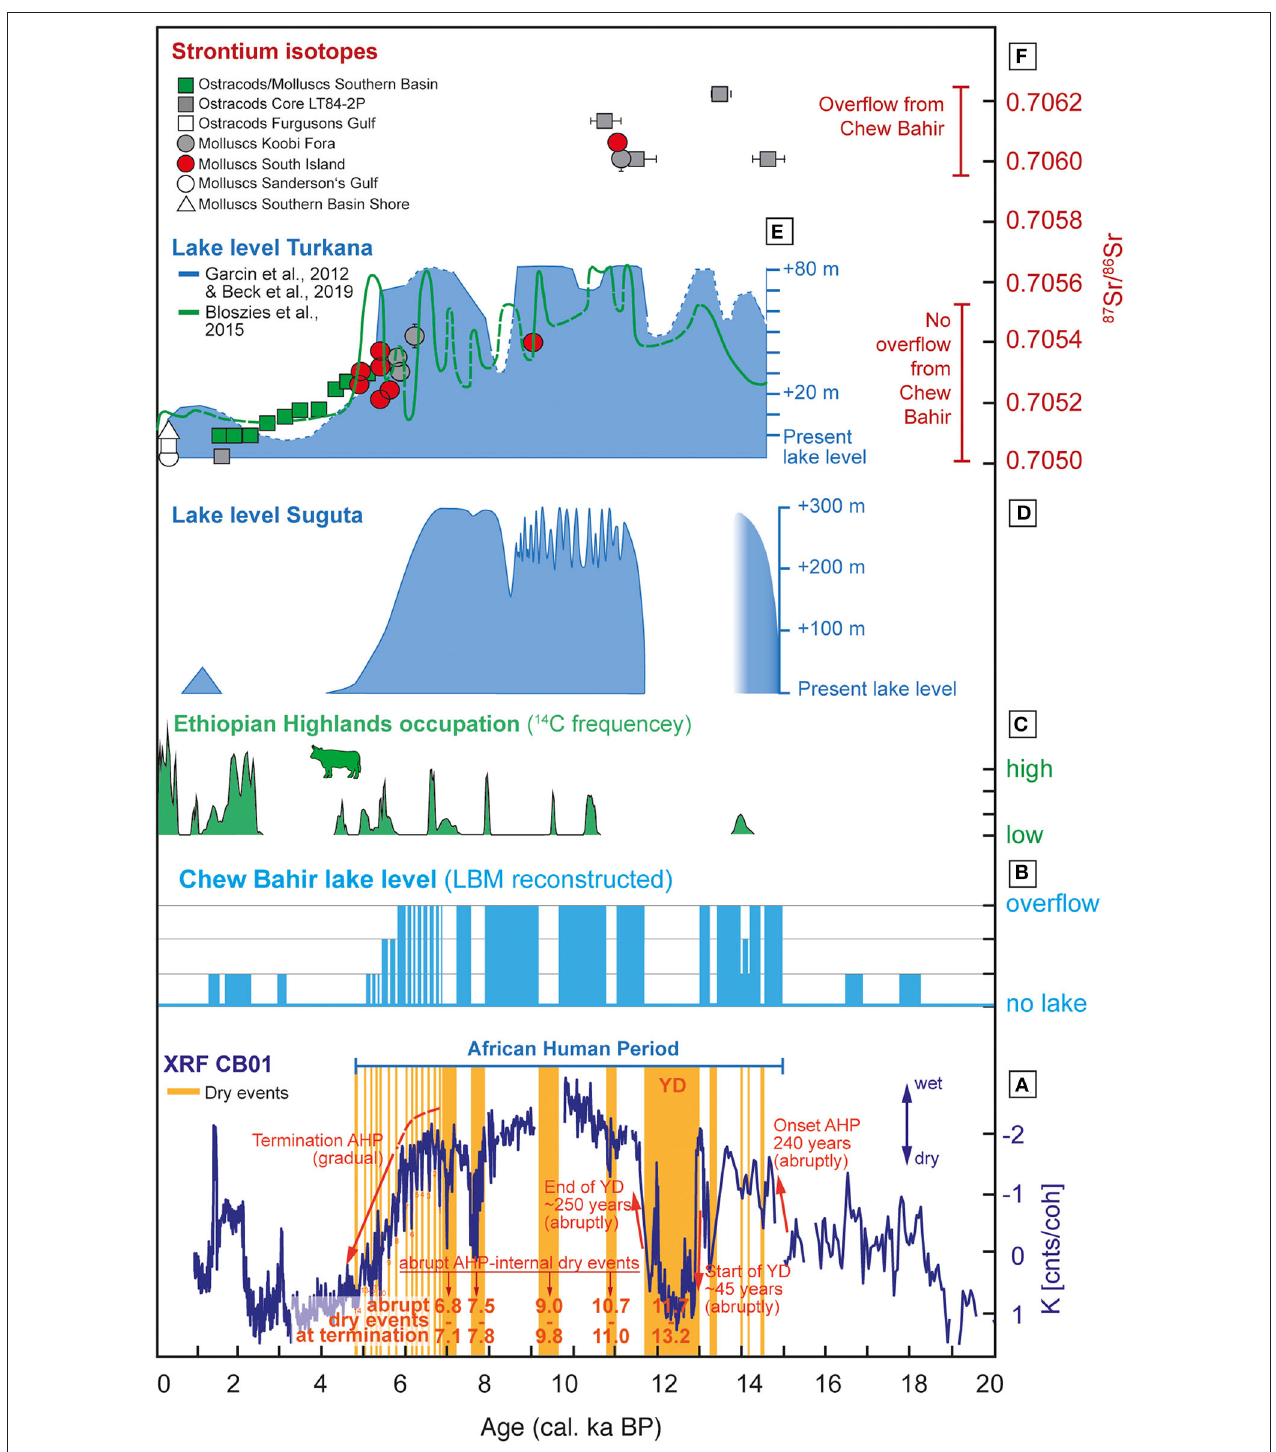
FIGURE 8 | Chew Bahir LBM-based paleo-lake level reconstruction and comparison to adjacent lakes: (A) CB01K proxy-record by Foerster et al. (2015) with dry events discussed in the text and transition modes. (B) Reconstructed lake level curve of Chew Bahir based on the lake-balance model (LBM) applied to changes in the K concentration of CB01. (C) Human occupation history of the Ethiopian highlands implies enhanced activities when lakes in the lower elevated rift basins, such as paleo-lake Chew Bahir became to saline or even dried up. The Ethiopian highlands may thus have been a refuge area during unfavorable times as Foerster et al. (2015) suggested. Cow indicates cultural transition from fishing/hunting/gathering to herding in the Ethiopian Highlands. (D) Lake level reconstruction of Suguta Valley (Junginger et al., 2014) as the mirror basin of Chew Bahir. (E) Lake level reconstruction of Lake Turkana by Garcin et al. (2012) and Beck et al. (2019) (blue, shaded curve), and by Bloszies et al. (2015) (green). (F) Strontium isotopes measured on aquatic fossils from lake Turkana sediments (van der Lubbe et al., 2017).